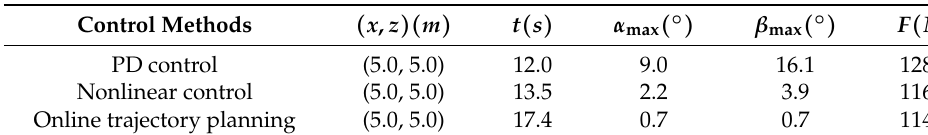
Table 1. Compare the quantitative results of the tests.